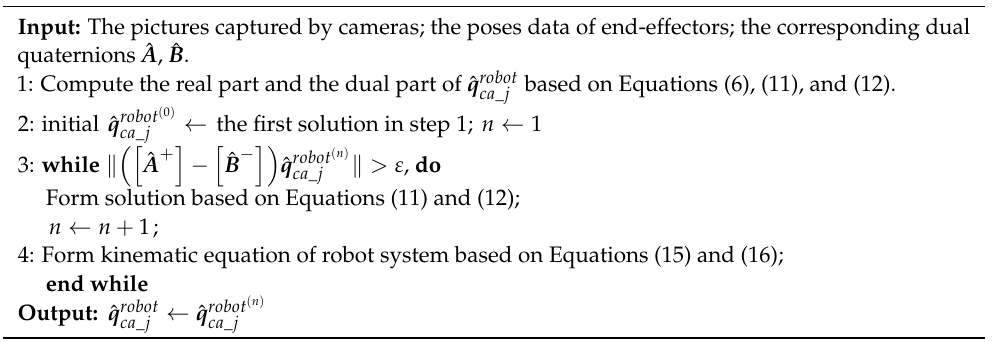
Algorithm 1: Modified hand–eye calibration for the dual-arm robot system using dual quaternion